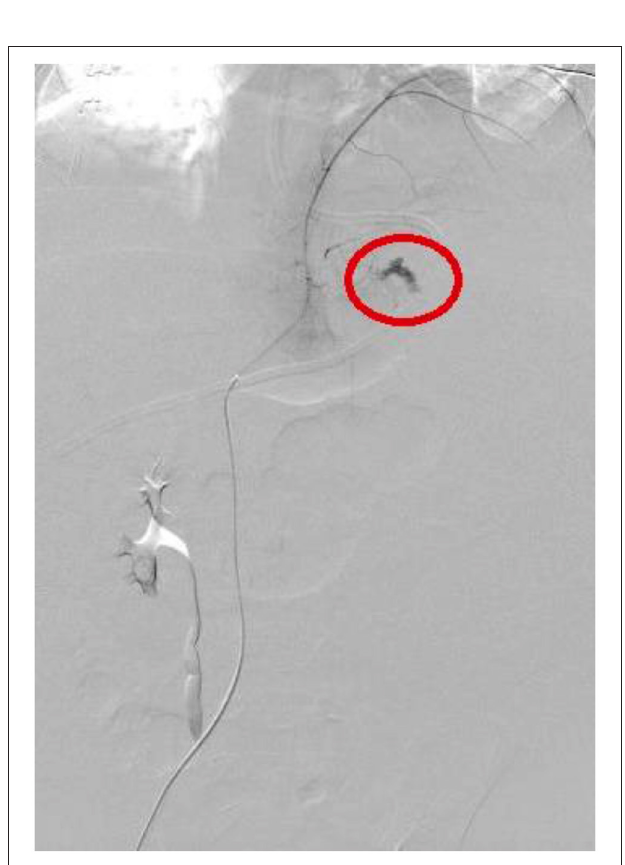
FIGURE 3 | Bleeding from left diaphragmatic artery (angiography: circle).